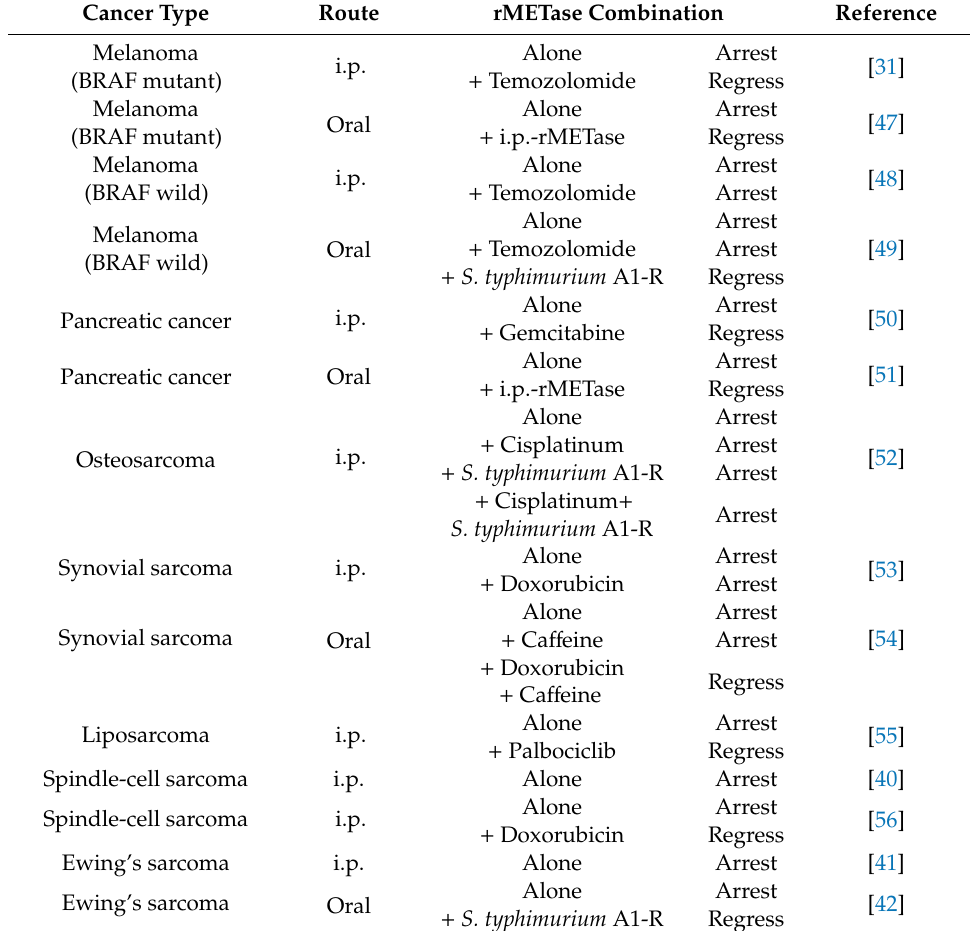
Table 1. Recombinant methioninase (rMETase) for patient-derived orthotopic xenograft